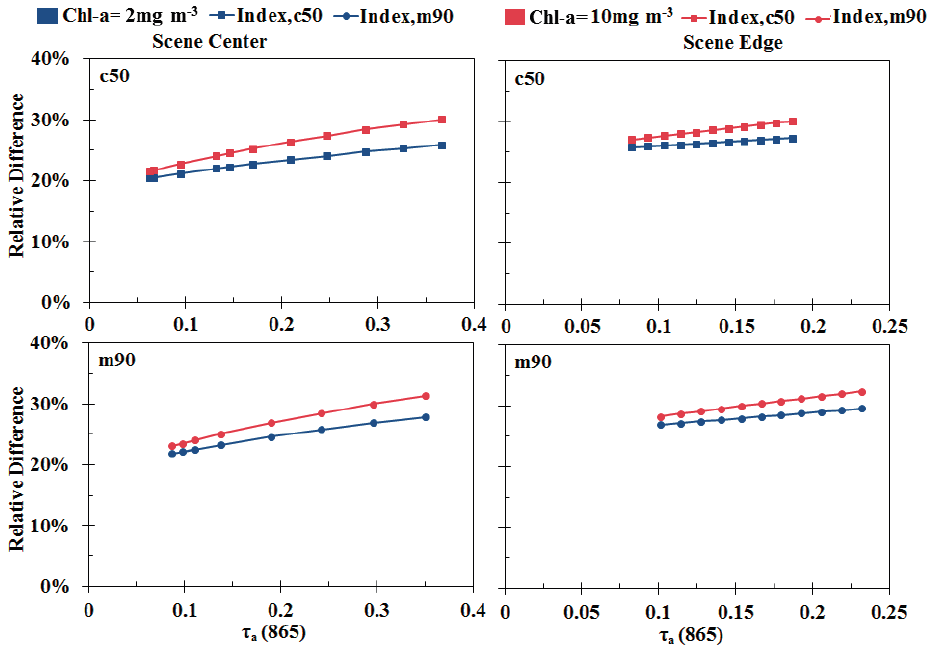
Figure 6. Relative difference between Chl-a derived from R rs (atmospherically-corrected remote sensing reflectance) and R rc (Rayleigh-corrected reflectance) using the same Equation (6). Two